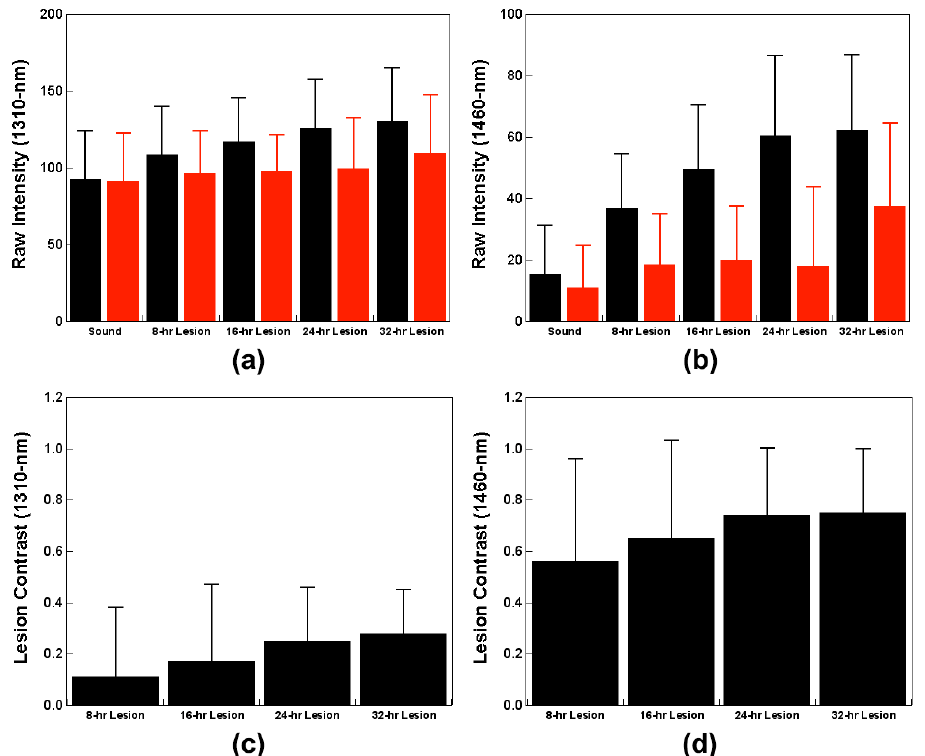
Figure 6. Mean ± S.D. for NIR SFE raw intensity measurements taken using ( a ) 1310-nm and ( b ) 1460-nm light, and lesion contrast measurements taken in the dry condition using ( c ) 1310-nm and ( d ) 1460-nm light. Left (black) bar in each group in raw intensity measurements ( a , b ) represents measurements taken when the samples were dry and the right (red) bar in each group represents measurements taken when the samples were